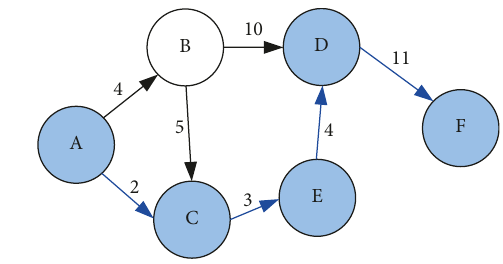
Figure 5: Shortest path